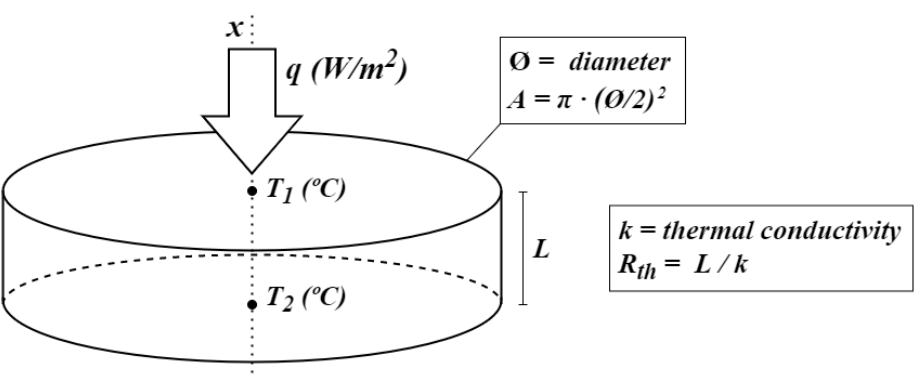
Figure 5. Heat flux sensor